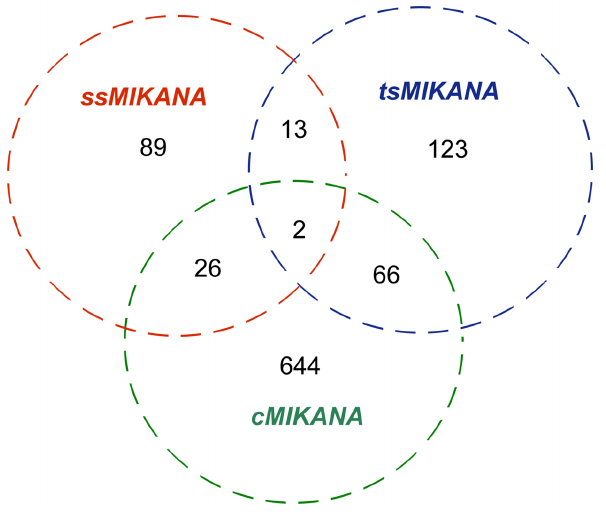
Figure 4. Venn diagram showing the network edges present in three inferred models. The edge-wise comparison between the ssMIKANA, tsMIKANA and cMIKANA models which were reconstructed from the related endothelial dataset is made.